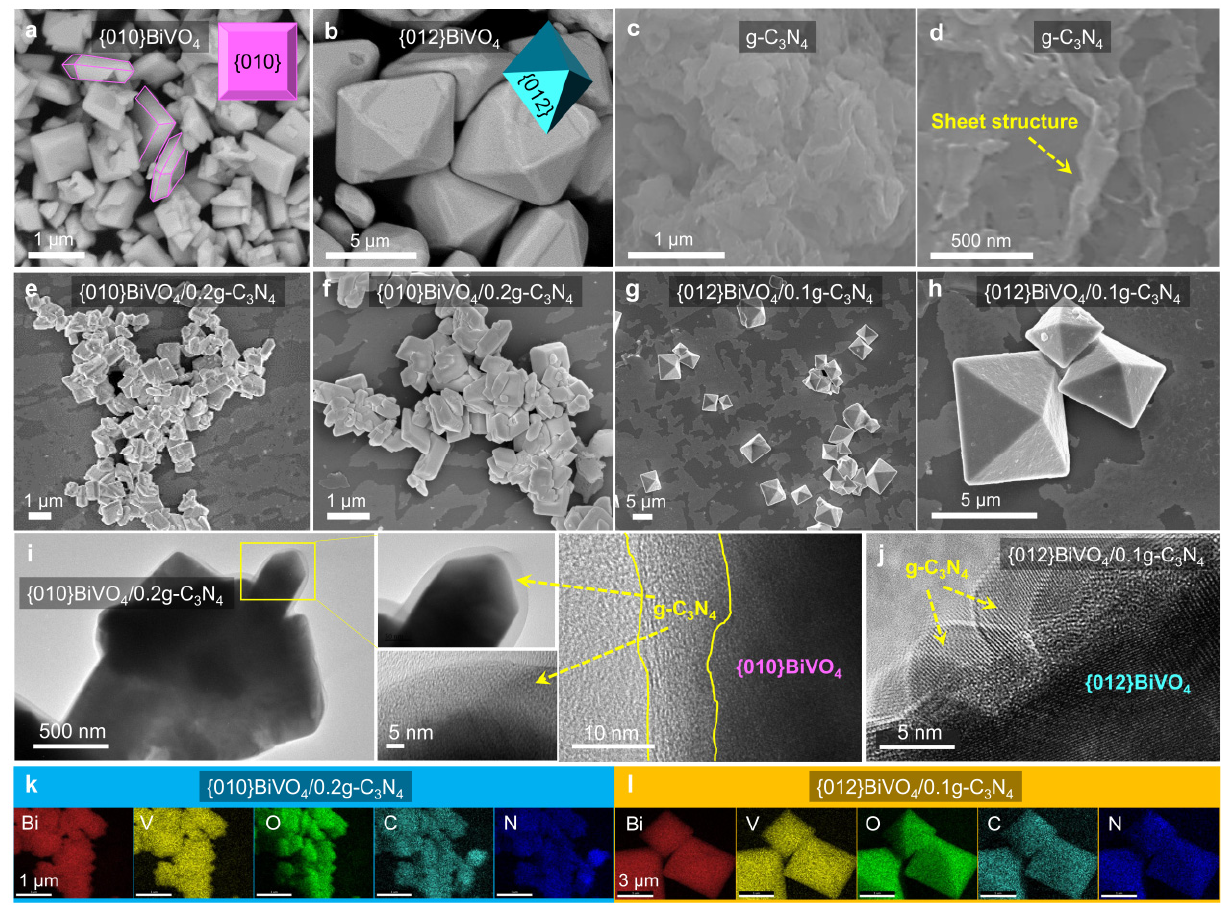
surfaces of {010}BiVO 4 and {012}BiVO 4 (elements of Bi, V, and O) manifesting the successful combinations between g-C 3 N 4 and {010}BiVO 4 or {012}BiVO 4 .